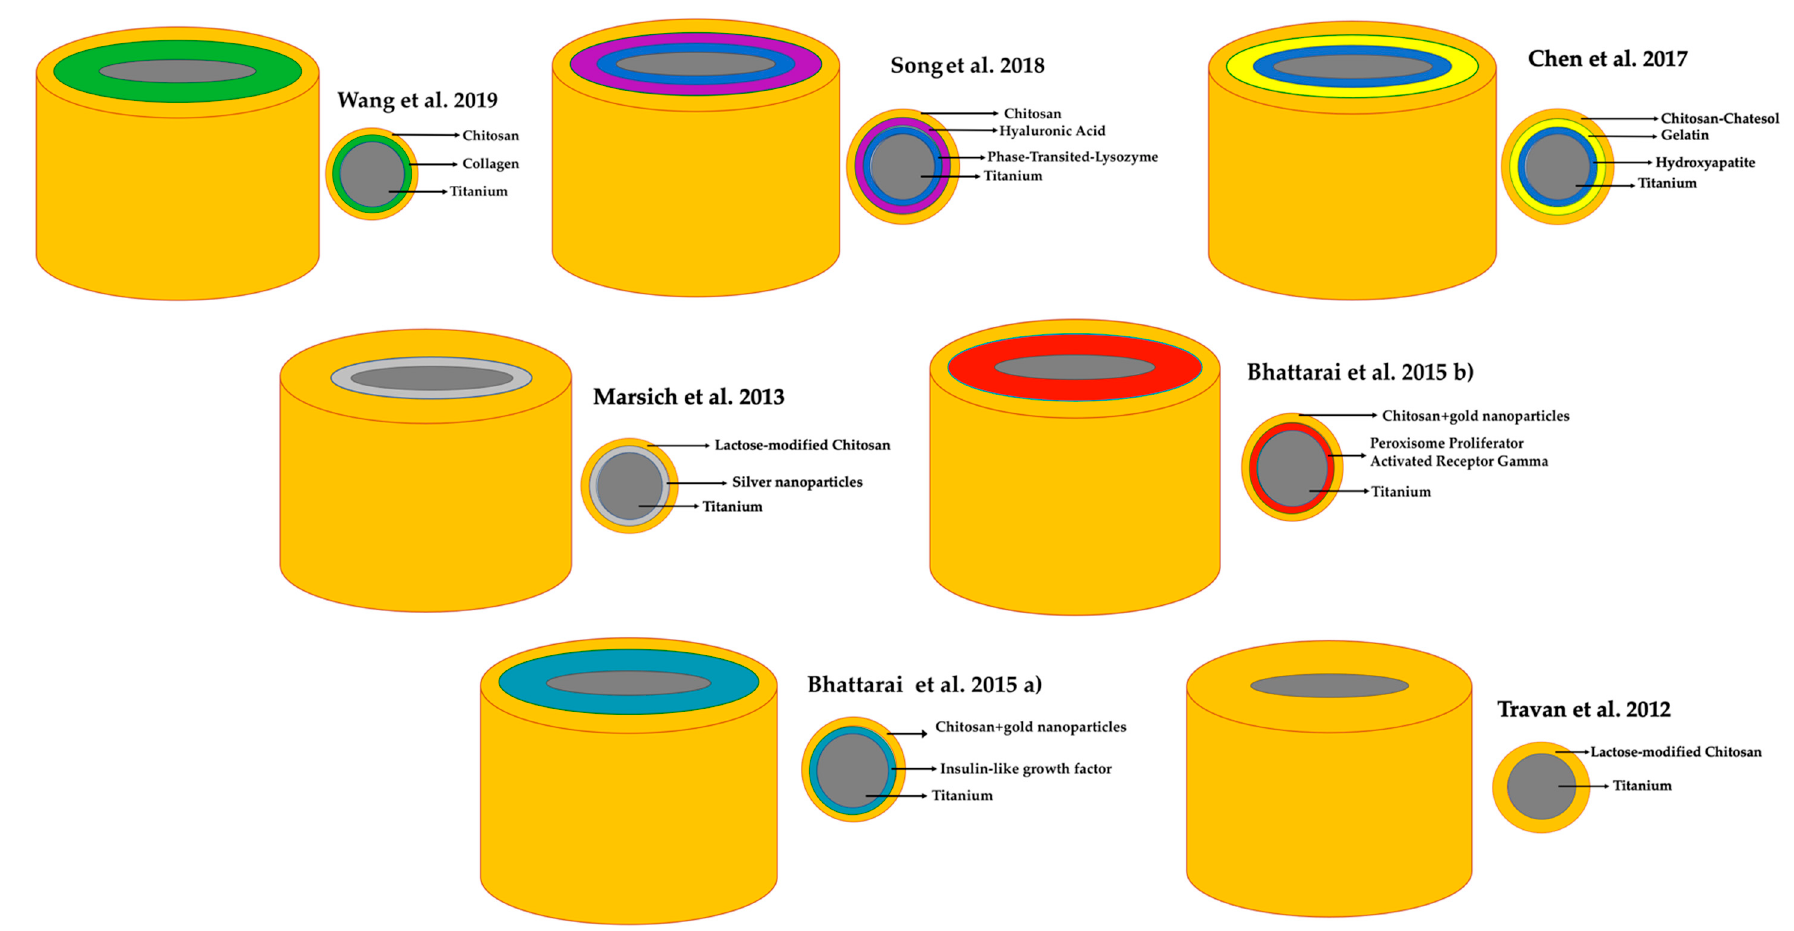
Figure 2. Graphic of CS incorporation to Ti in included studies.